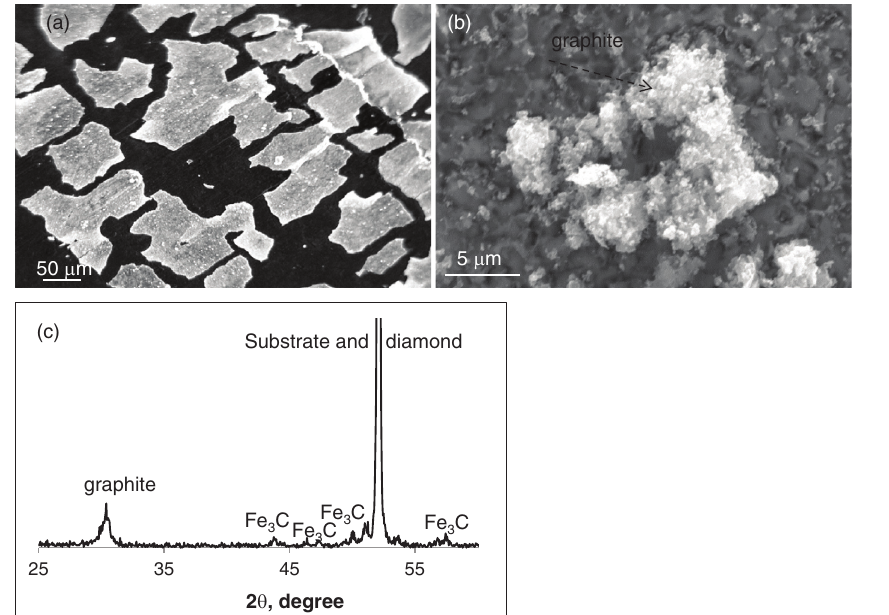
Figure 7: Surface SEM images (a – b) and XRD patterns of diamond coatings deposited on Kovar substrate showing local spallation and carburization related to deficiency in the Al